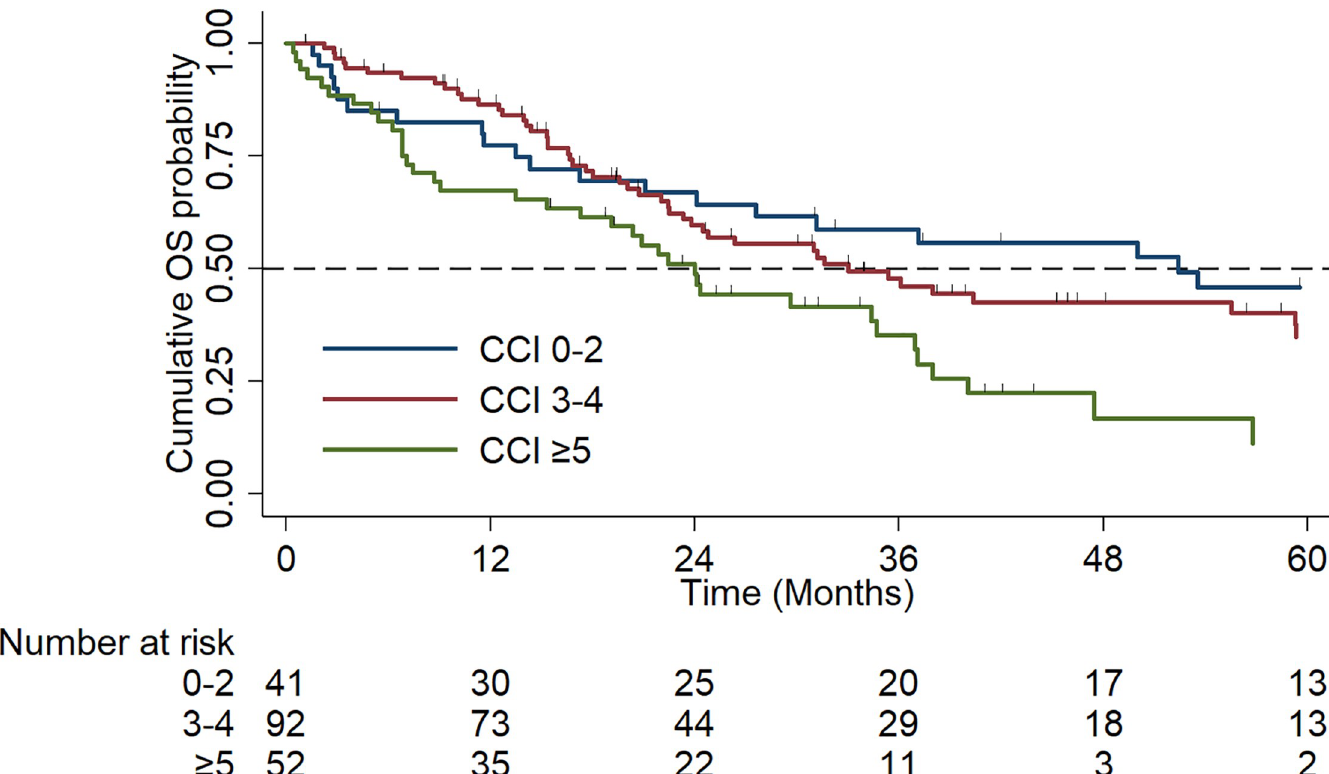
Fig 6. Kaplan Meier Curves of overall survival (OS) by Co-morbidity Index (mild (0–2) vs. moderate (3–4) vs. severe ( � 5)).